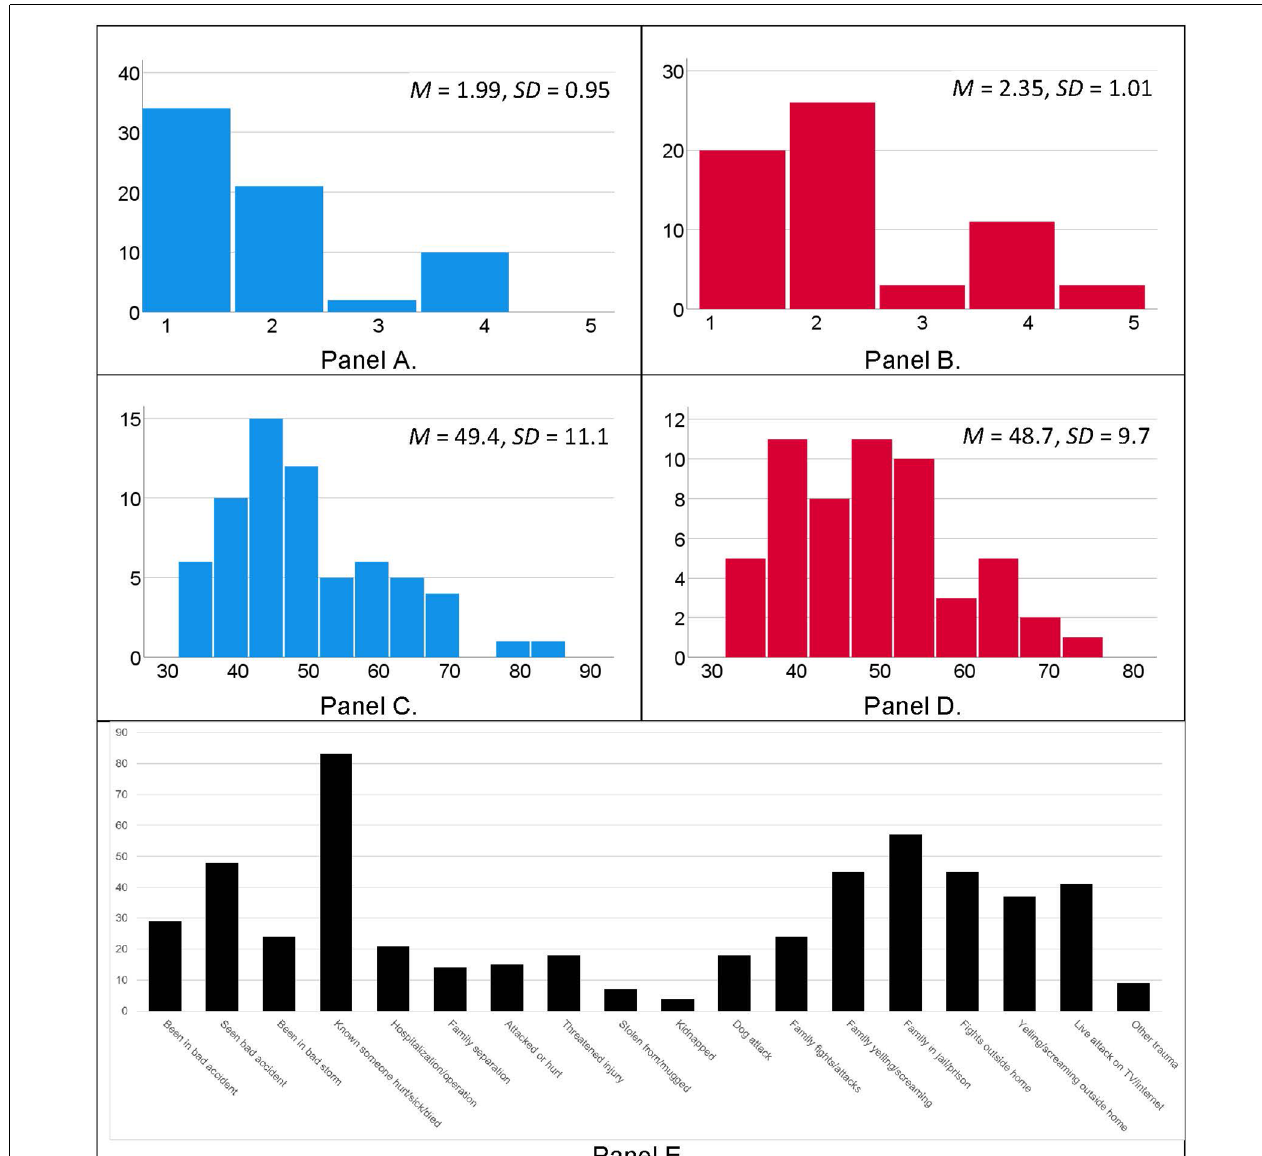
FIGURE 1 | Histograms depicting pubertal development scores for boys (Panel A , blue bars) and girls (Panel B , red bars), and age- and sex-normed anxiety T -scores from the BASC-2 for boys (Panel C , blue bars) and girls (Panel D , red bars). Histogram of child-reported exposure to traumatic events, per the Traumatic Exposure Screening Inventory (TESI; Panel E , black